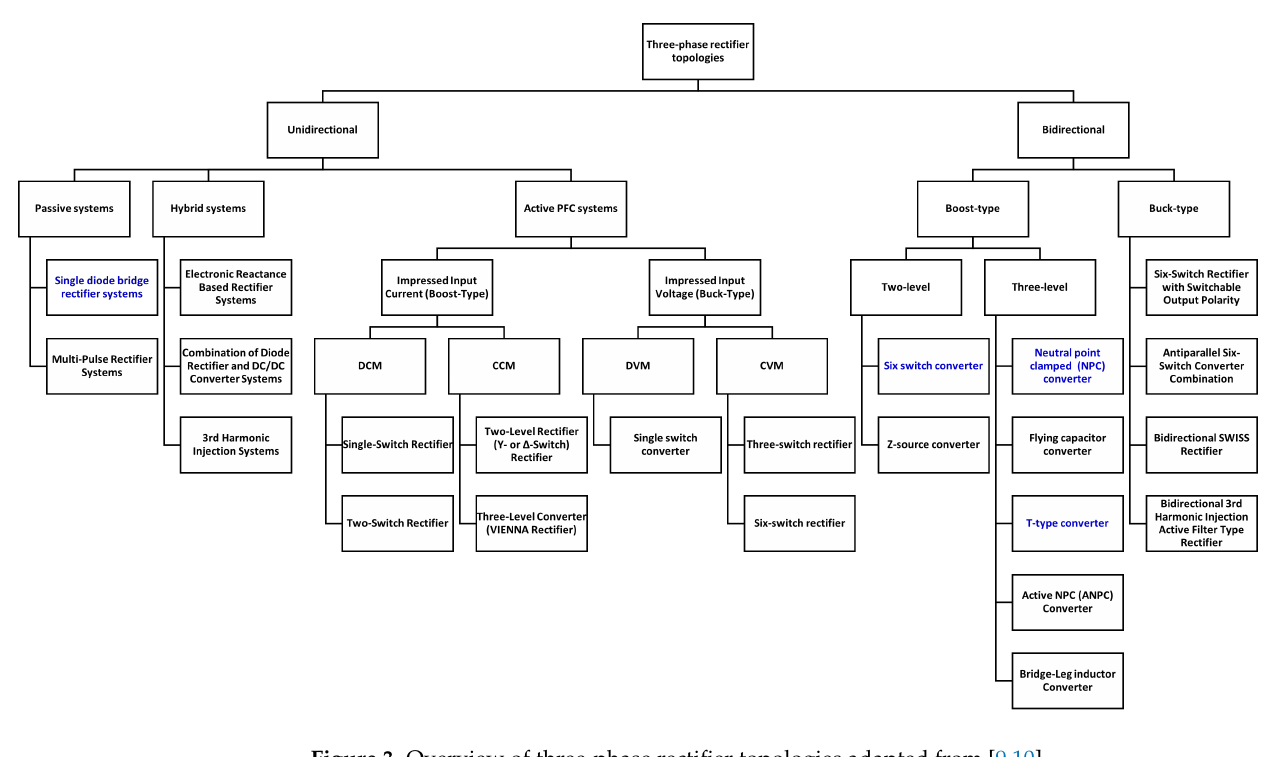
Figure 3. Overview of three-phase rectifier topologies adapted from